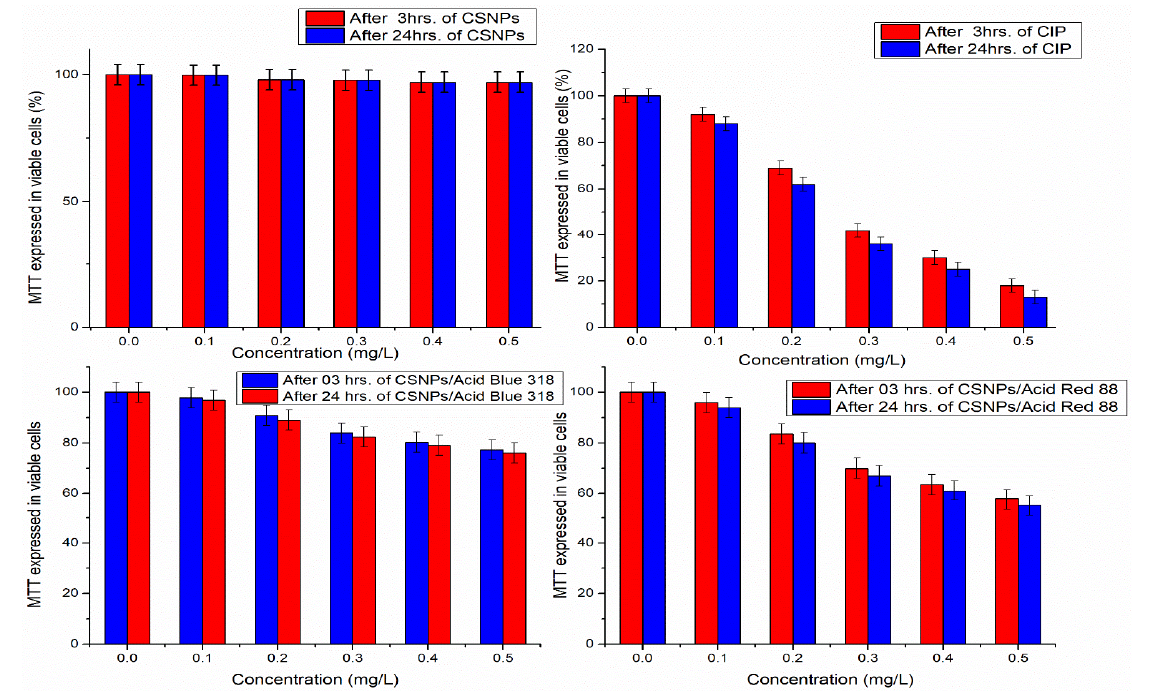
Figure 11. Mitochondrial metabolic activity (MTT) assay expressed in viable cells of chitosan nano- particles (CSNPs), ciprofloxacin (CIP), CSNPs composite with Acid Red 88 and Acid Blue 318 after 3 and 24 h, cell culture.